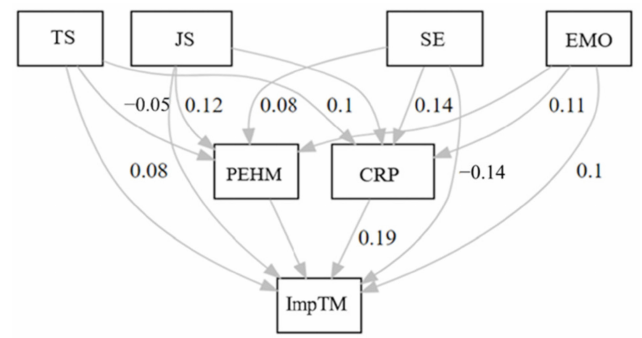
Figure 1. Model 1: COVID-19 pandemic impacts on teaching methods. Note: TS = teachers’ stress, JS = job satisfaction, SE = Self-efficacy, EMO = emotional intensity at work, CRP = perception of risk of contracting SARS-CoV-2; PEHM = Perception of the effectiveness of health measures; ImpTM: impact of COVID-19 on teaching methods. Only coefficients of statistically significant paths (solid lines) are reported.